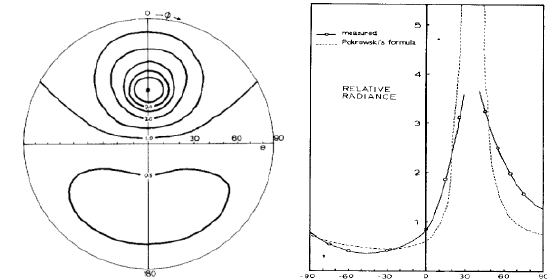
Figure 4. Relative radiance values for solar zenith angle = 35